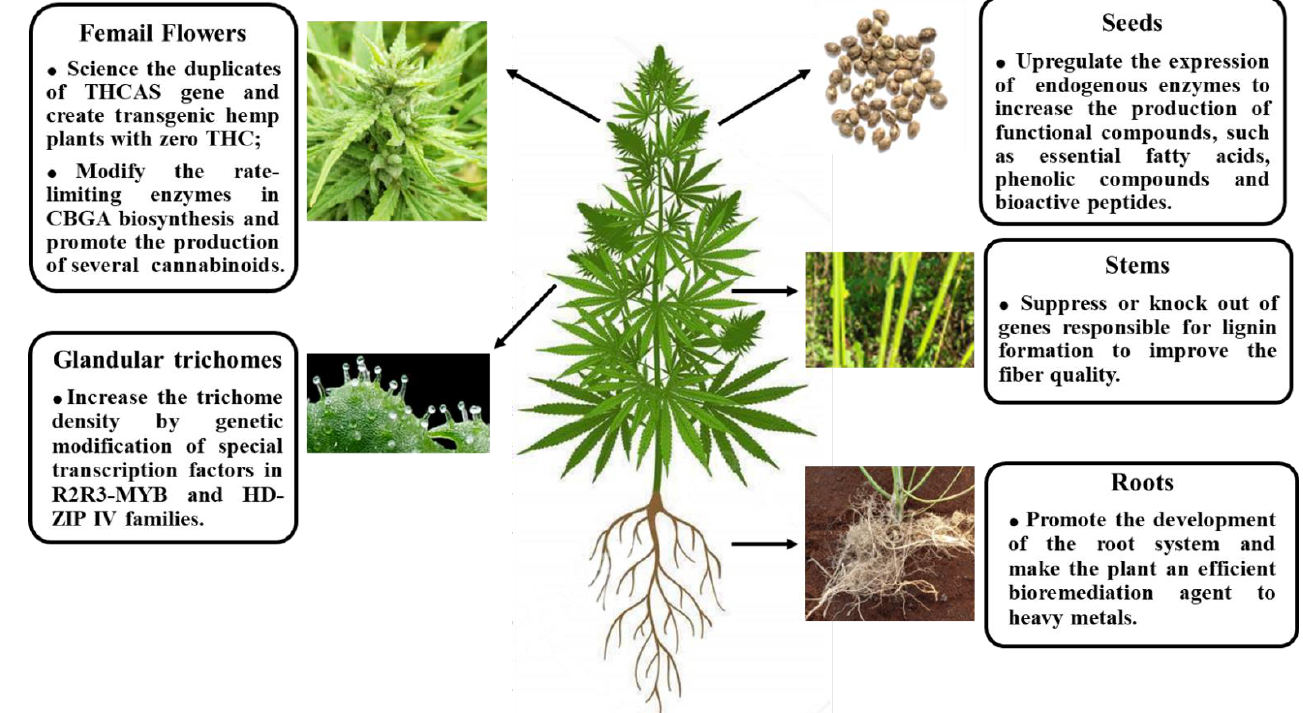
Figure 1. Gene editing can help to fulfill the potential usefulness of Cannabis in multiple fields, including bioenergy, textiles, food, and ecological restoration.